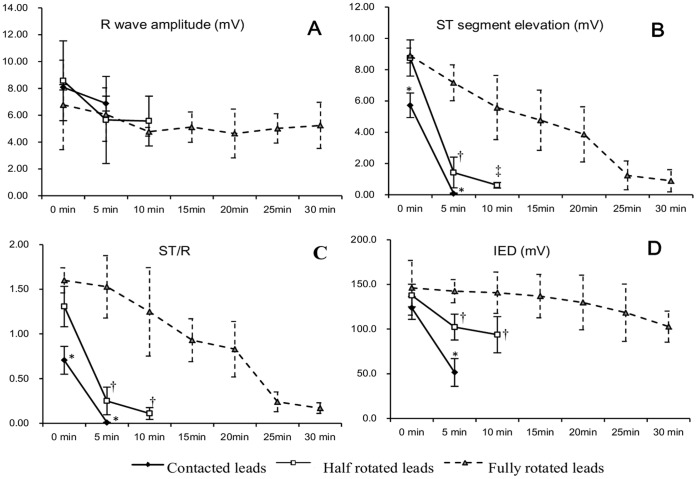
Comparison of Intracardiac EGM variables derived from isolated rabbit hearts.Panel A. Intrinsic R wave amplitude showed no significant dissimilarity regarding to different lead positionings. Panel B. Contacted leads presented the smallest magnitude of ST-segment elevation with the most rapid decline, followed by half rotated leads, while fully rotated leads showed the biggest COI amplitude and the slowest recovery. Note that there was no difference between half and fully rotated leads at 0 min. Panel C and D depicted the same findings as Panel B in the value of ST/R and IED, respectively. *: p<0.05 (compared with half and fully rotated leads); †: p<0.05 and ‡: p<0.01 (compared with fully rotated leads).